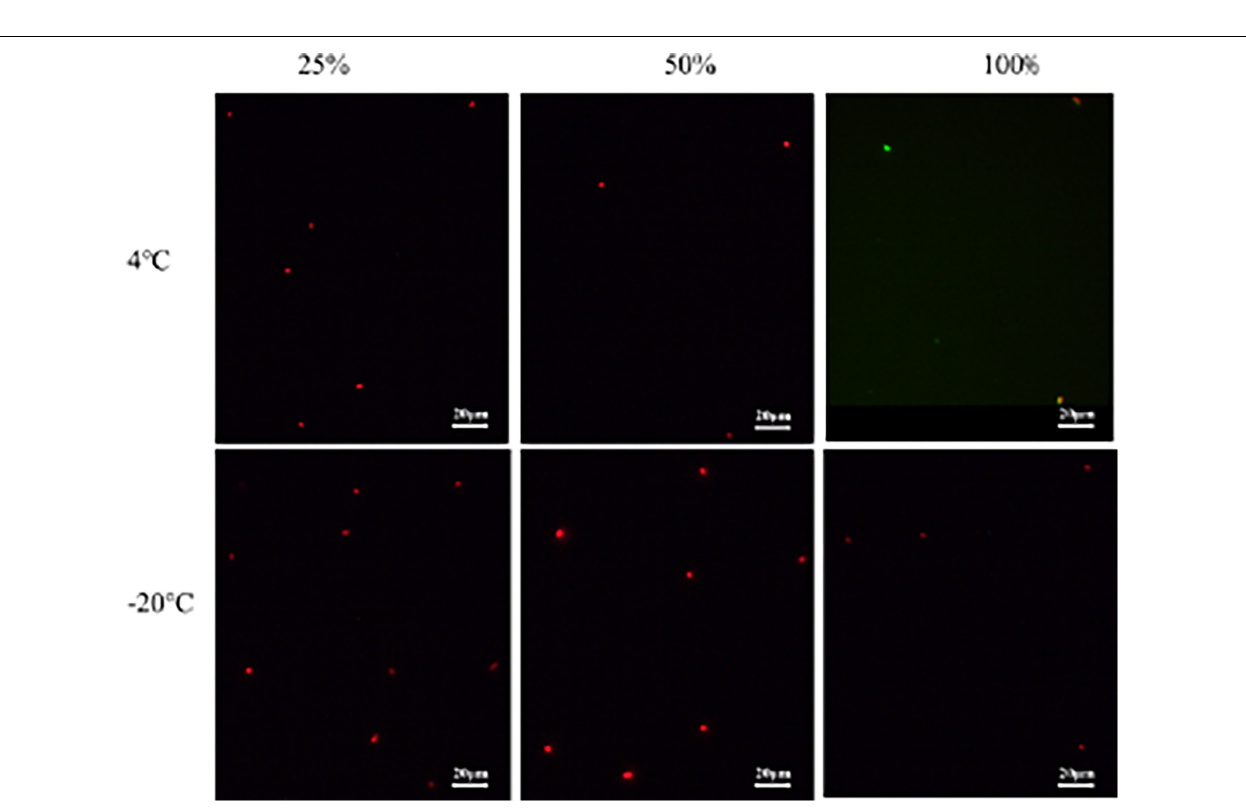
Frontiers in Microbiology |